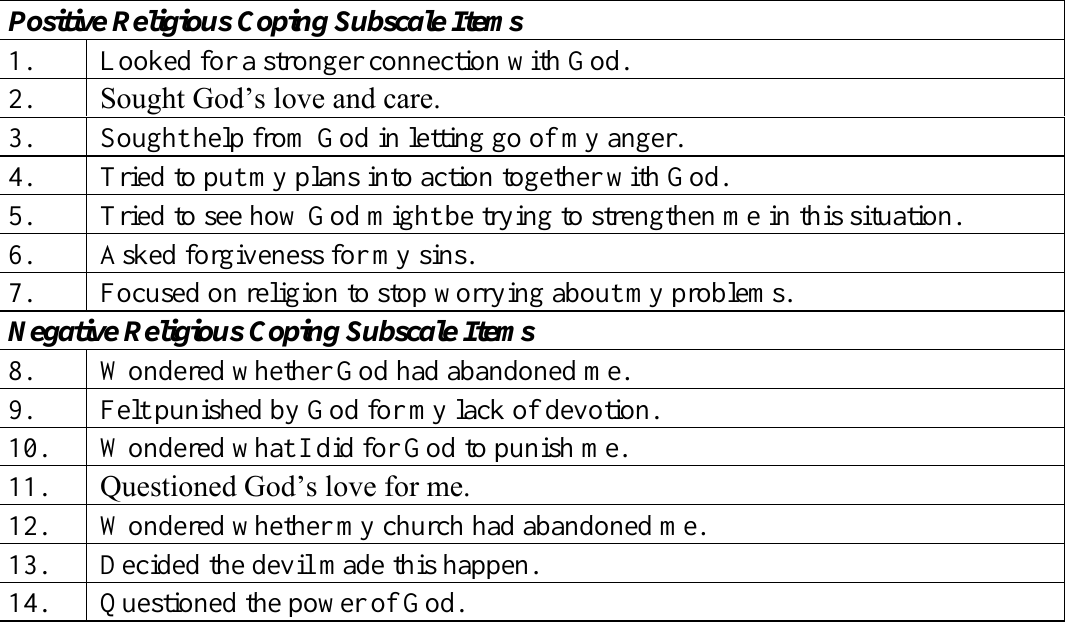
Table 2. The Brief RCOPE: Positive and Negative Coping Subscale